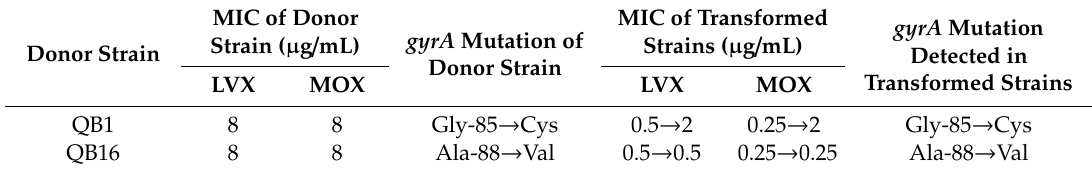
Table 5. Transformation of H. pylori Using gDNA isolated from resistant strains (2017 / 2018). MIC of Transformed MIC of Donor gyrA Mutation Strains ( µ g / mL) Strain ( µ g / mL) gyrA Mutation of Donor Strain Detected in Donor Strain Transformed StrainsLVX MOX LVX MOX QB1 8 8 Gly-85 → Cys 0.5 → 2 0.25 → 2 Gly-85 → Cys QB16 8 8 Ala-88 → Val 0.5 → 0.5 0.25 → 0.25 Ala-88 →